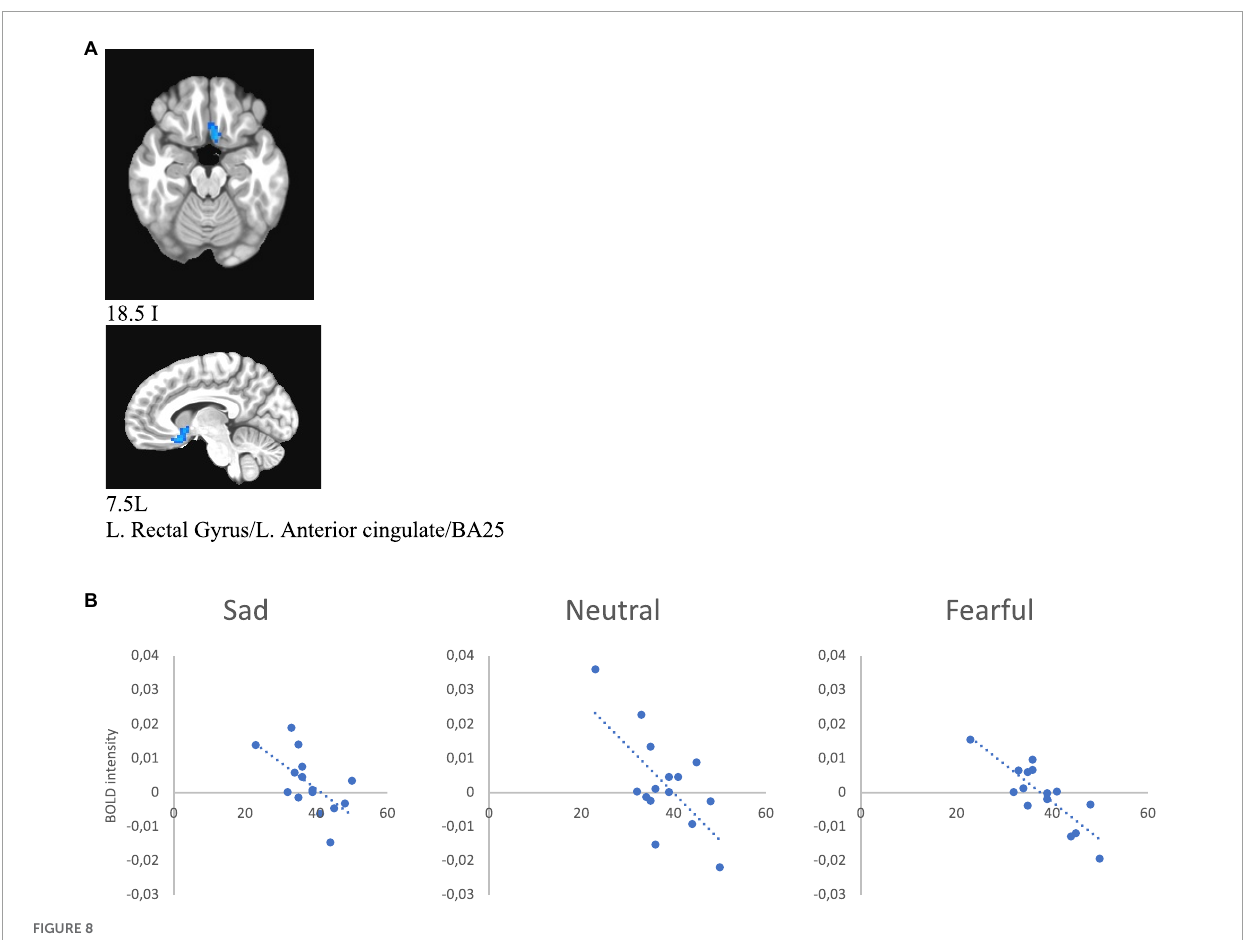
TABLE 6 Regions with significant correlations between BOLD signal intensity during emotional face processing and IDS and melancholic scores in MDD group. Cluster # Cluster size (# voxels) Center of mass Peak activation Brodmann area BOLD signal and IDS score 1 50 +7.5 − 13.5 − 18.5 Left rectal gyrus BOLD signal and melancholic